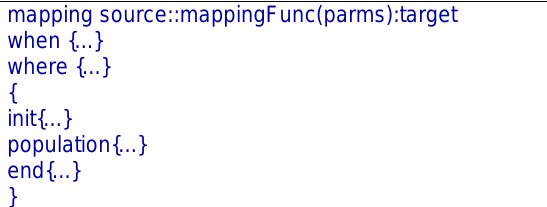
Fig. 3. The general syntax for the body of a mapping